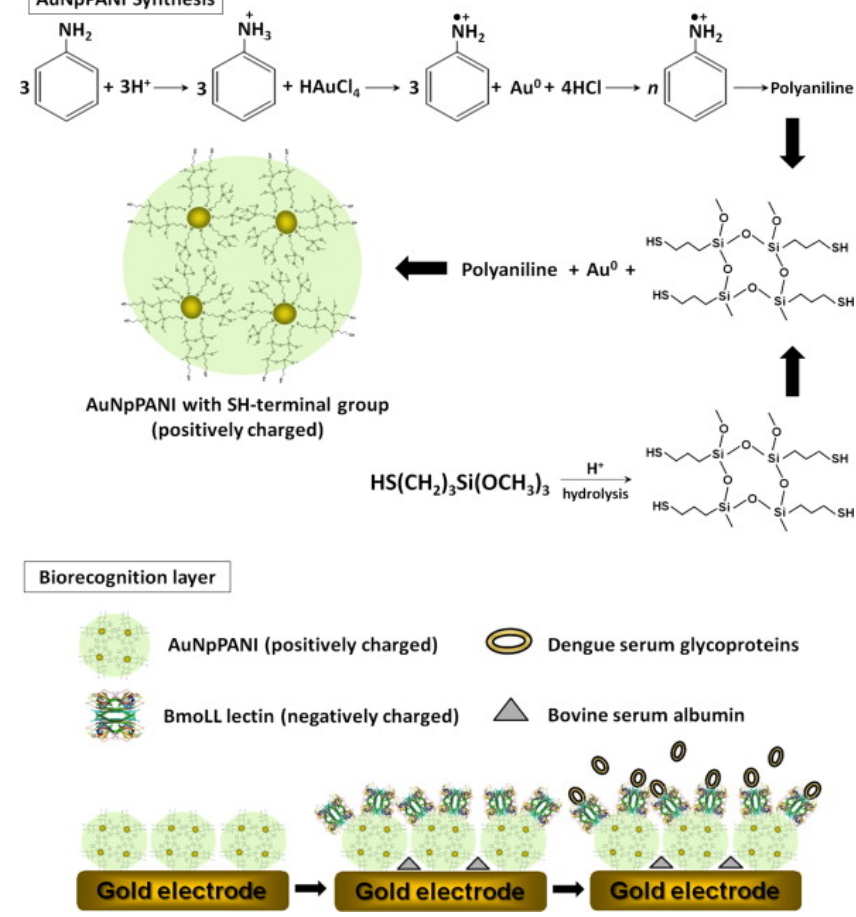
Figure 2. Mechanism for the reaction of aniline with chloroauric acid trihydrate and schematic representation of the AuNpPANI-BmoLL-BSA-DEN biosensor system (Retrieved from [65]).